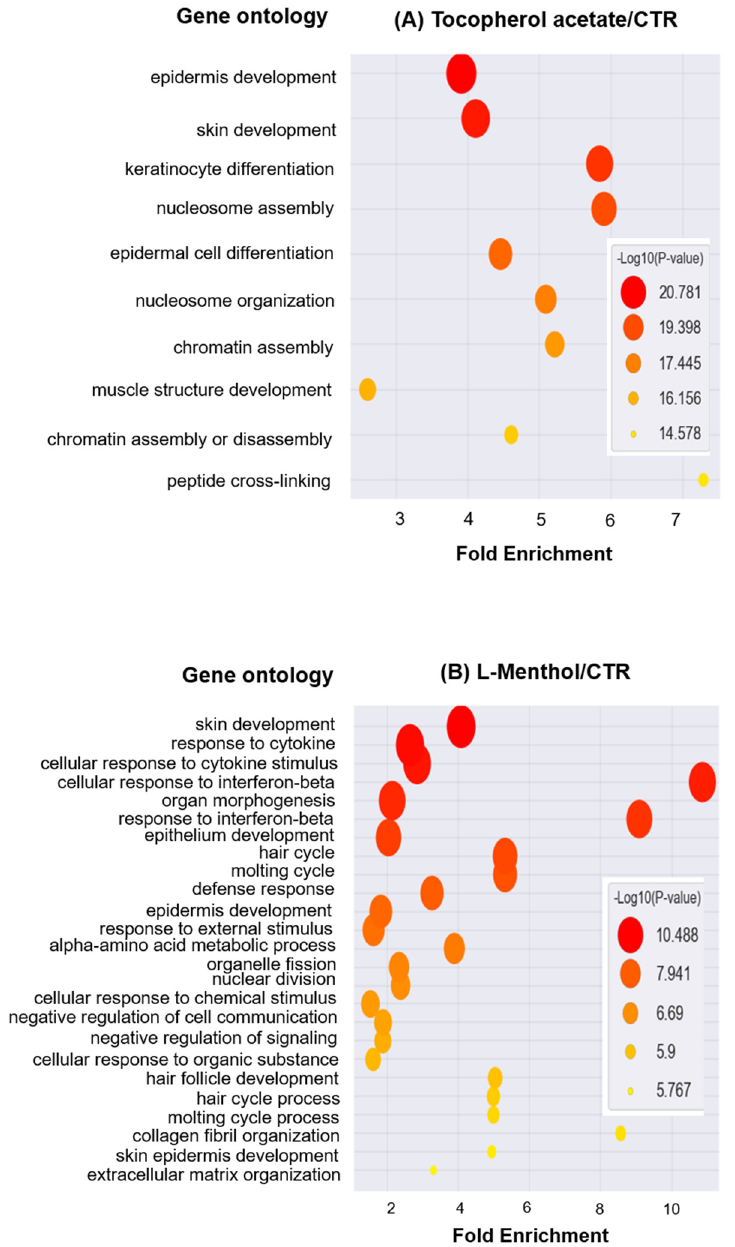
Figure 6. Functional annotation enrichment for tocopherol acetate ( A ) and L-menthol ( B ) treatment groups. DAVID bioinformatics resources 6.8 analysis tool was used.